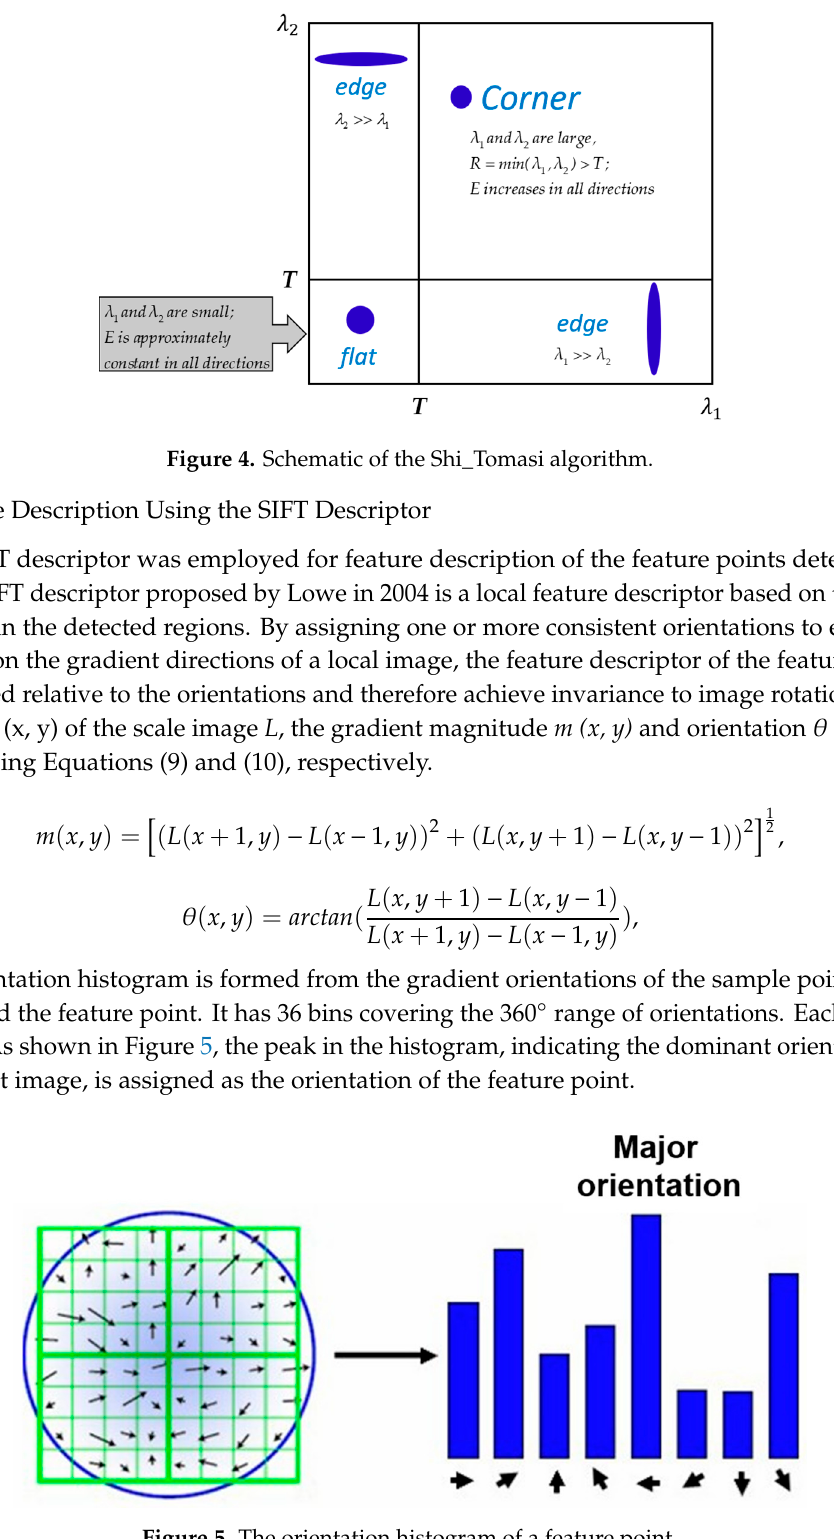
Figure 5. The orientation histogram of a feature point .